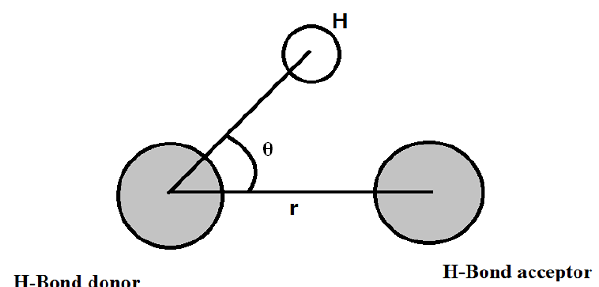
Figure 3. Geometrical hydrogen bond criterion.